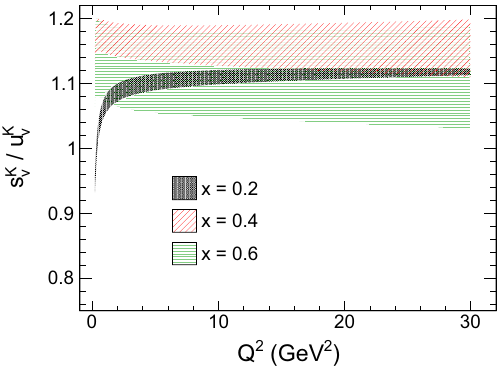
Fig. 9 The obtained ratio s K v / u K v as a function of Q 2 with the strange quark mass effect is considered in the parton splitting processes of the DGLAP evolution. The error bands show the 3 σ uncertainties of the ratio